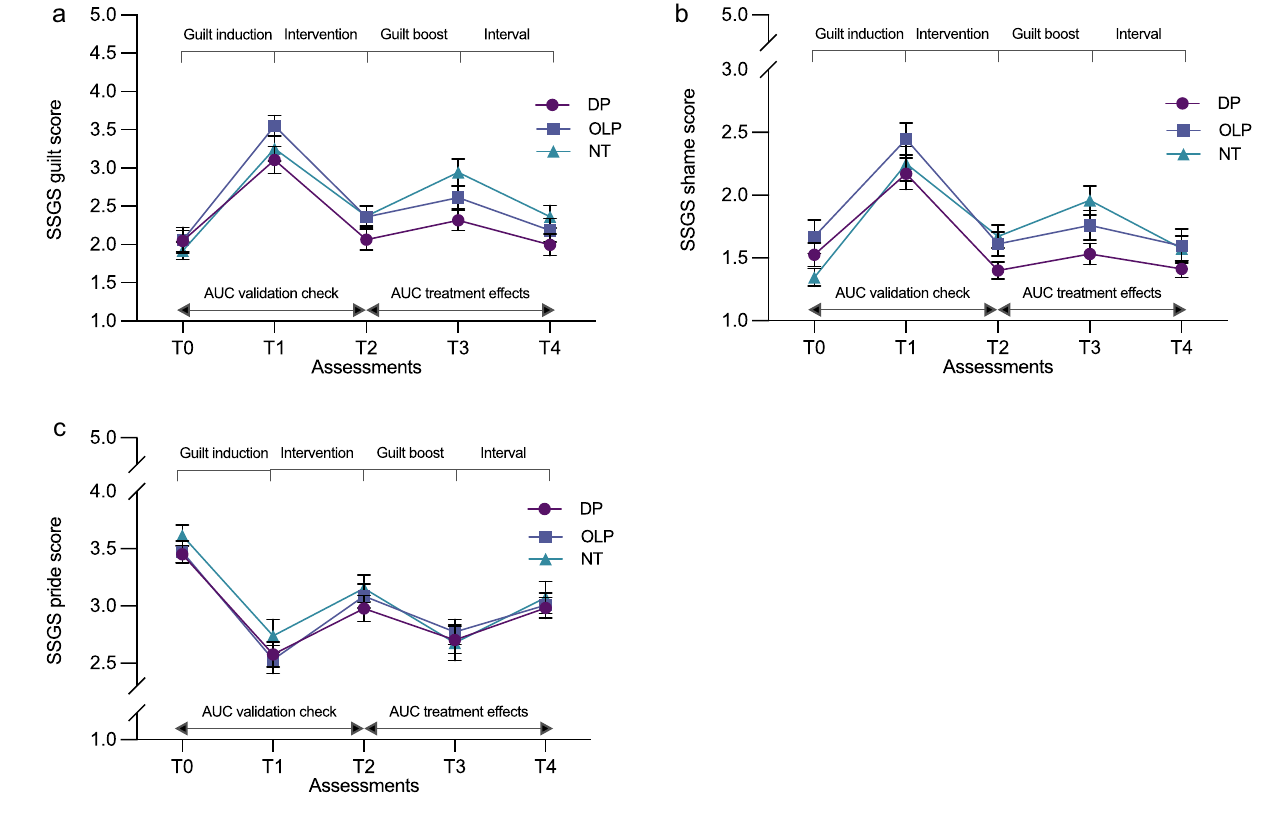
Figure 2. Temporal course of the SSGS guilt ( a ), shame ( b ) and pride ( c ) scale scores across experimental groups. Note: Displayed are means per group: error bars represent the standard error of the mean. DP, deceptive placebo; OLP, open-label placebo; NT, no treatment; SSGS, State Shame and Guilt Scale; AUC, area under the curve.